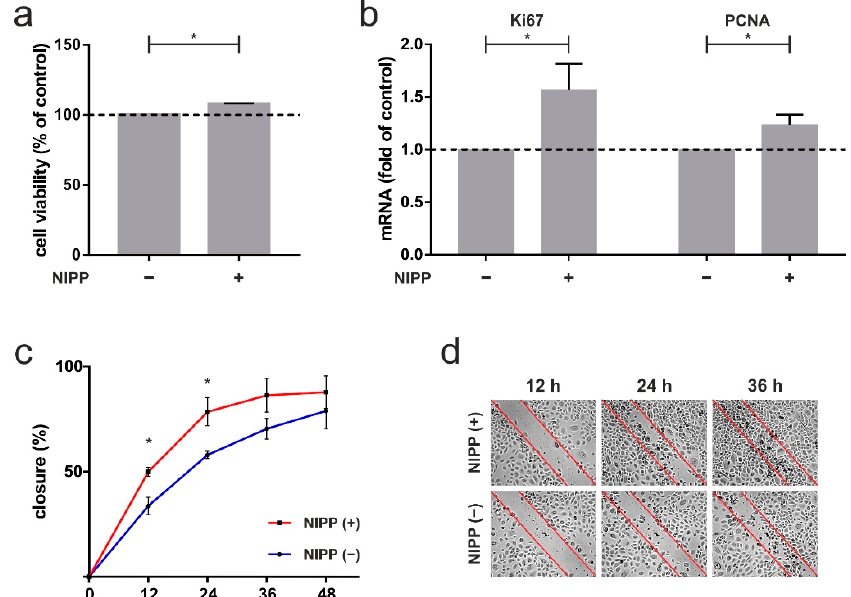
Figure 5. The 60 s NIPP treatment of primary human gingival keratinocytes (HPGK) at one day. ( a ) Influence of NIPP on cell viability, shown by XTT assay, n = 6; ( b ) impact of NIPP on mRNA level of proliferation markers Ki67 and PCNA, n = 6; ( c ) in vitro wound healing assay, displayed by scratch assay, n = 5; ( d ) representative images are visualized. * statistical significance ( p < 0.05).